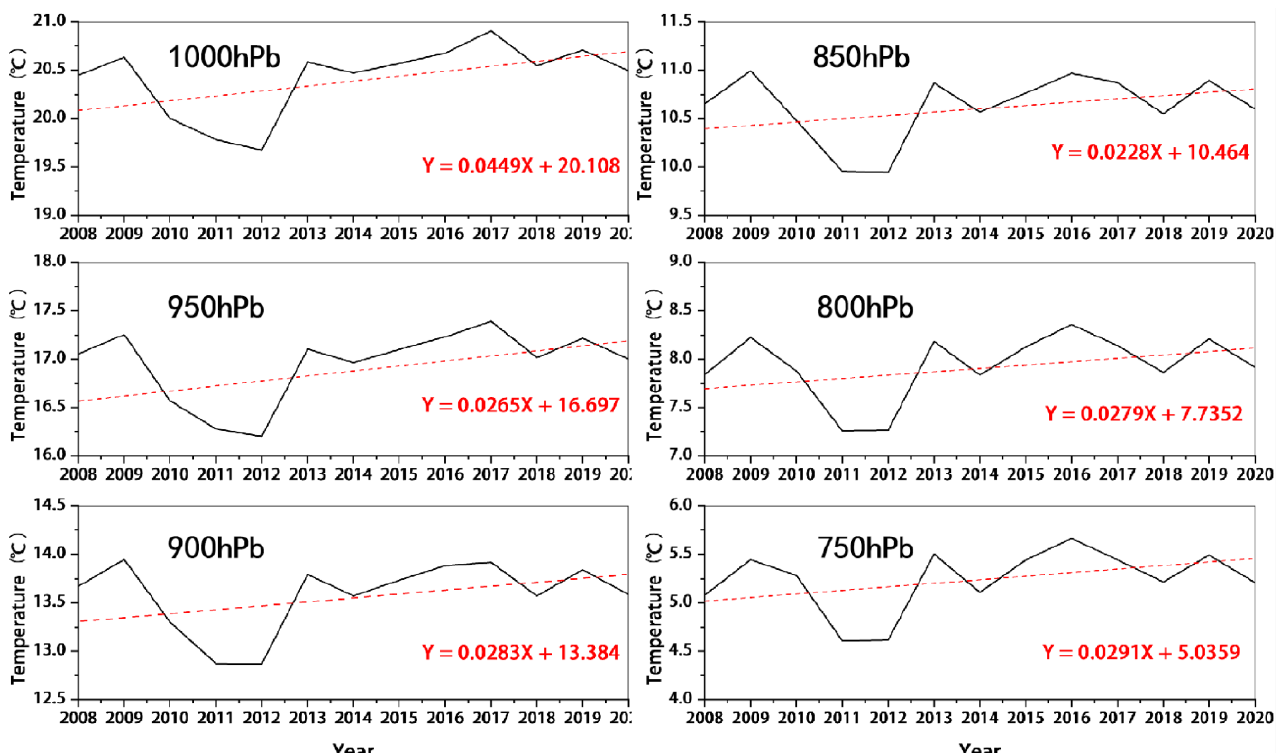
Figure 12. Variation trend of temperature at different altitudes in the lower troposphere from 2008 to 2020.